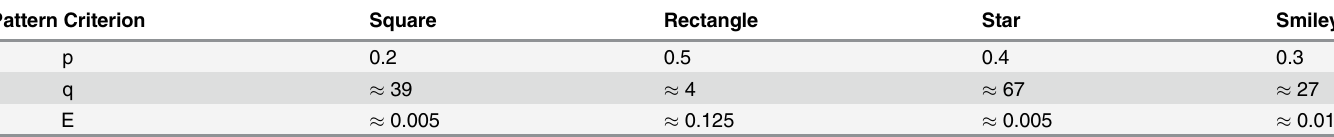
Table 2. Strength and efficiency of DNA Origami assemblers. Values are roughly estimated based on their Monte Carlo sampling of the assembled prod- ucts, with p being estimated as the smallest fraction of well-formed subpatterns in the target pattern and q being estimated as the complement of his fidelity (fraction of correct origamis.) Due to incomplete information, these estimates disagree with the general perception that origami protocols are efficient assemblers. Pattern